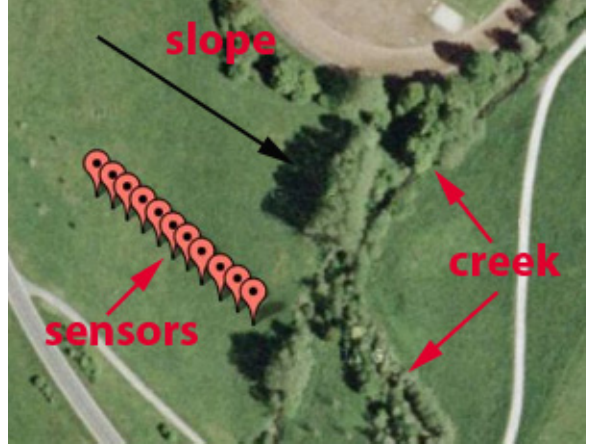
Figure 2. Observation area with